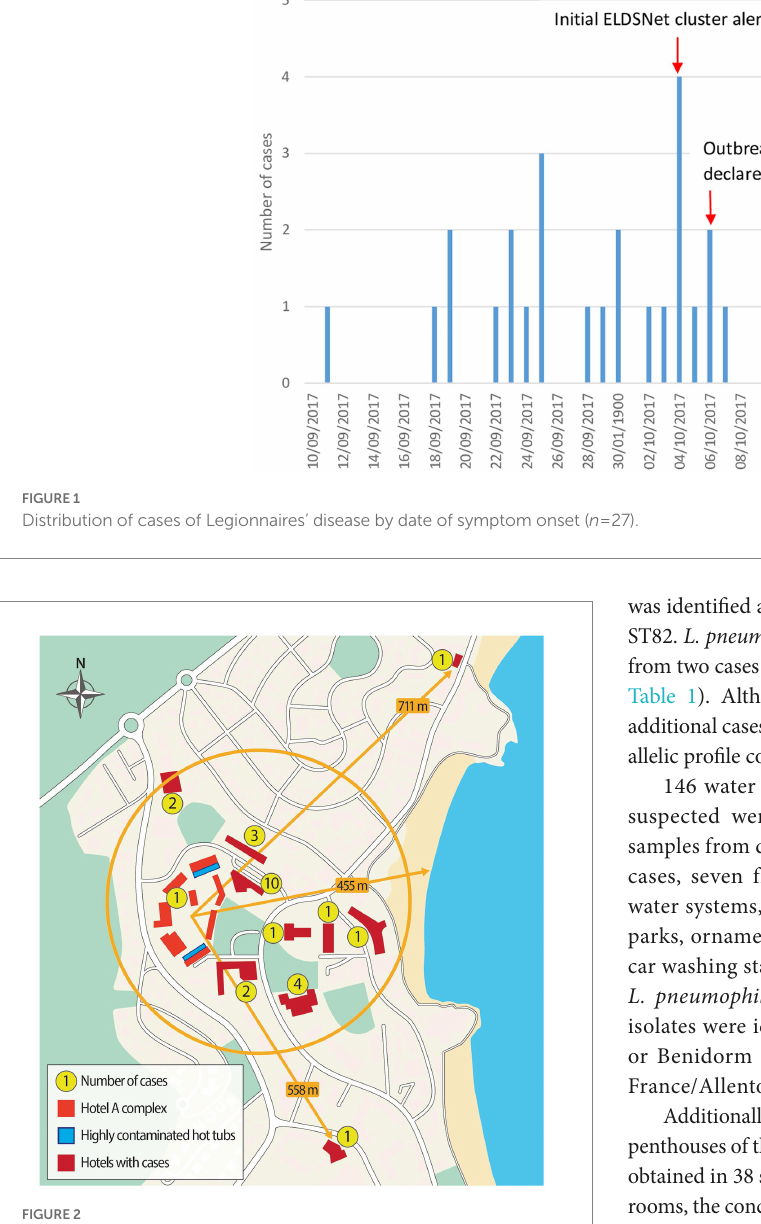
FIGURE 2 Schematic diagram of the affected area, accommodation sites associated with cases, and some selected